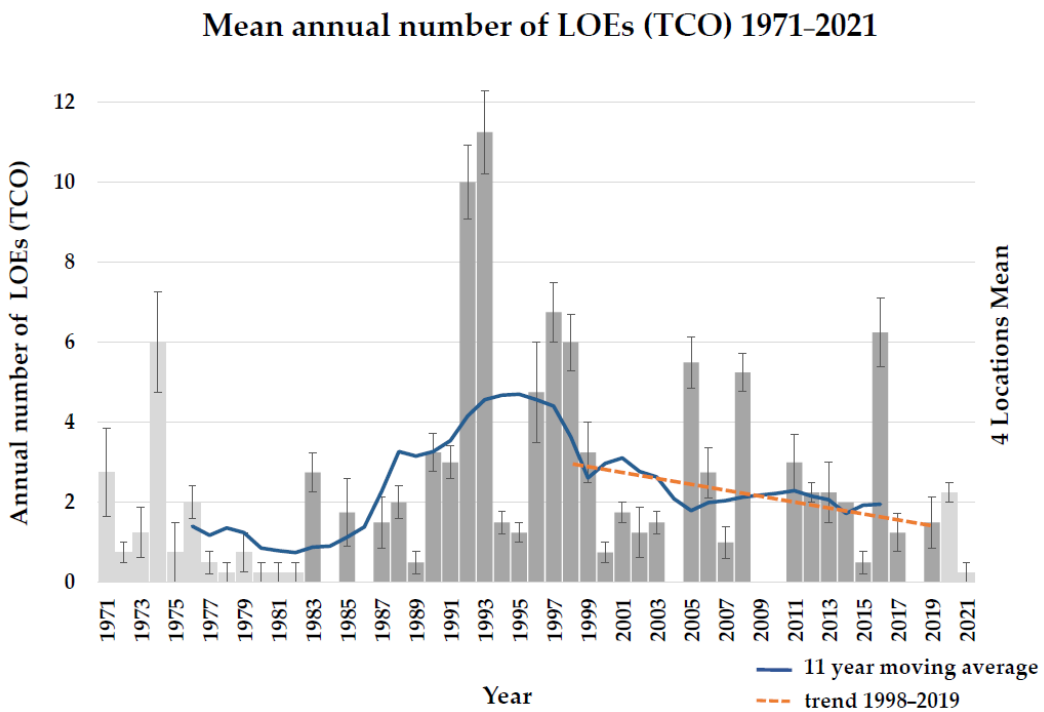
Figure 3. Mean annual number of LOEs (TCO) in the period 1971–2021 together with the 11-year moving average (blue line) and the linear trend of the subperiod 1998–2019 (orange dashed line), (4-location means and standard deviations).